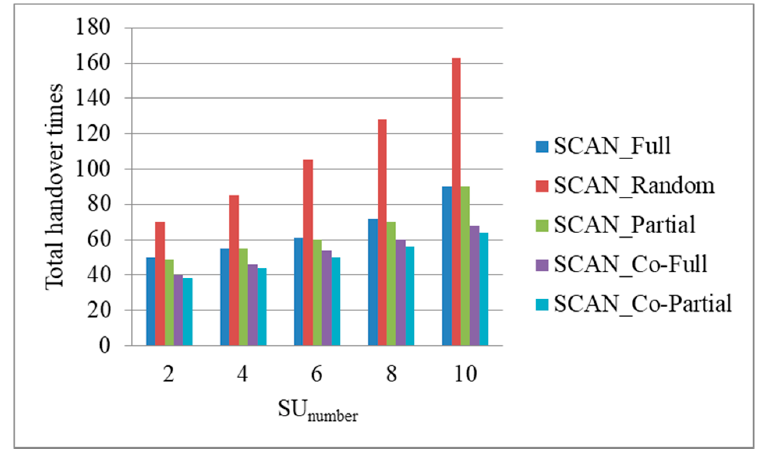
Figure 19. The total number of spectrum handovers under different number of SU cars (PU number = 10, P PUaccess = 0.5, V = 10).